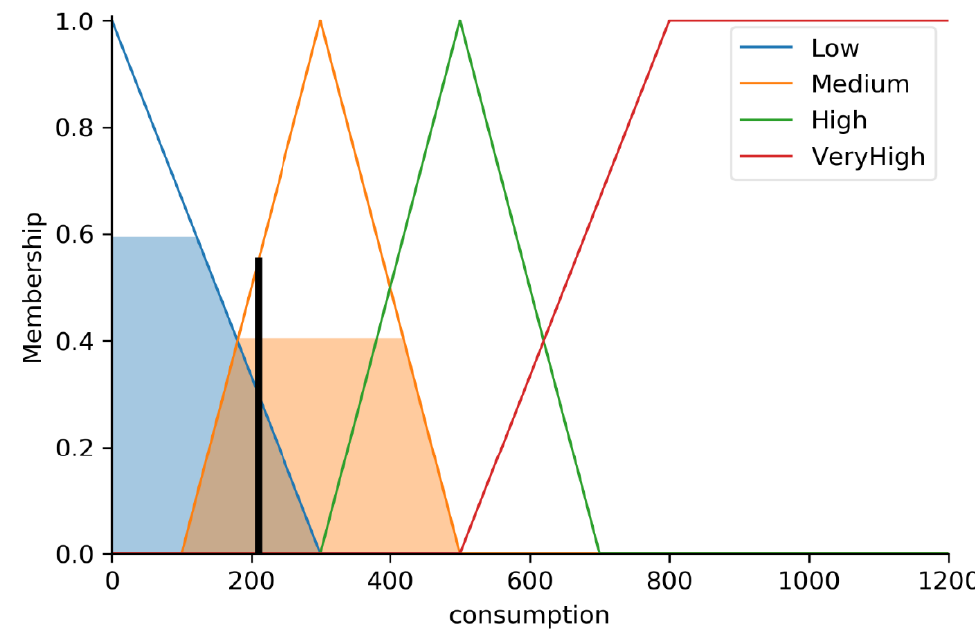
Figure 7. Sample response of the fuzzy control system for the computation of energy consumption. The resulting fuzzy sets are derived from the highlighted blue and orange surface areas and the bold black line denotes the optimally typical energy consumption value after the defuzzification process.